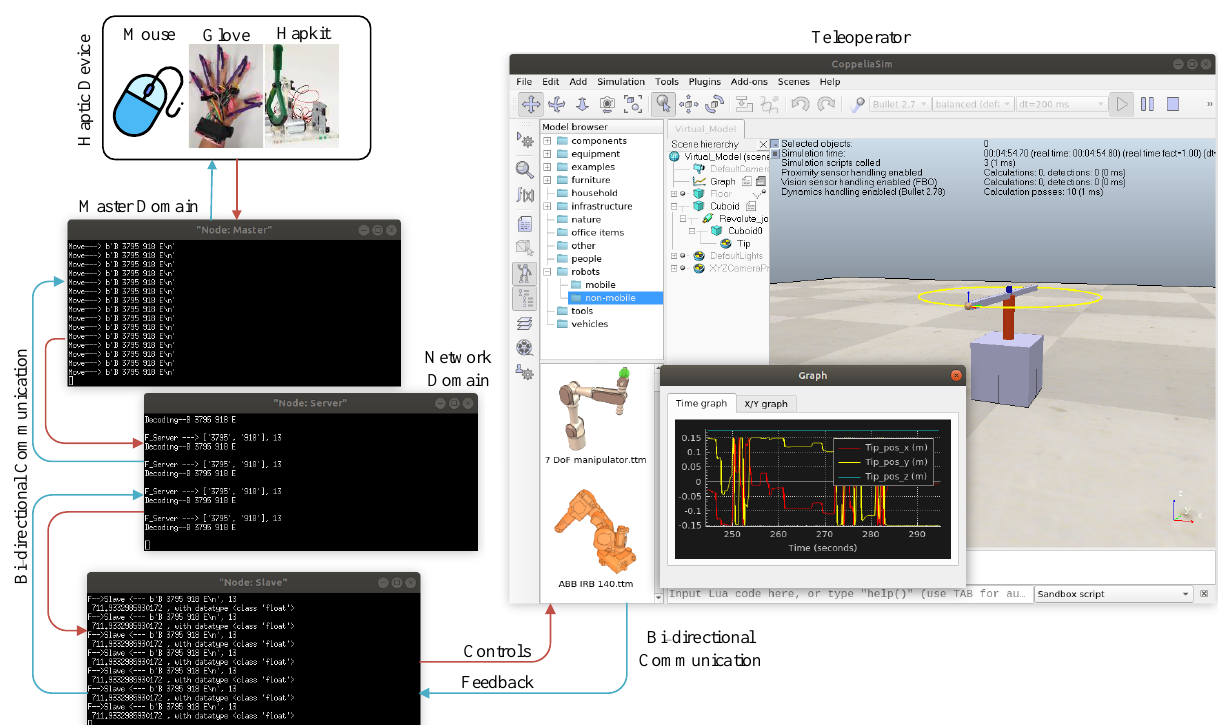
Figure 11. IoTactileSim interface for scenario II experiment.